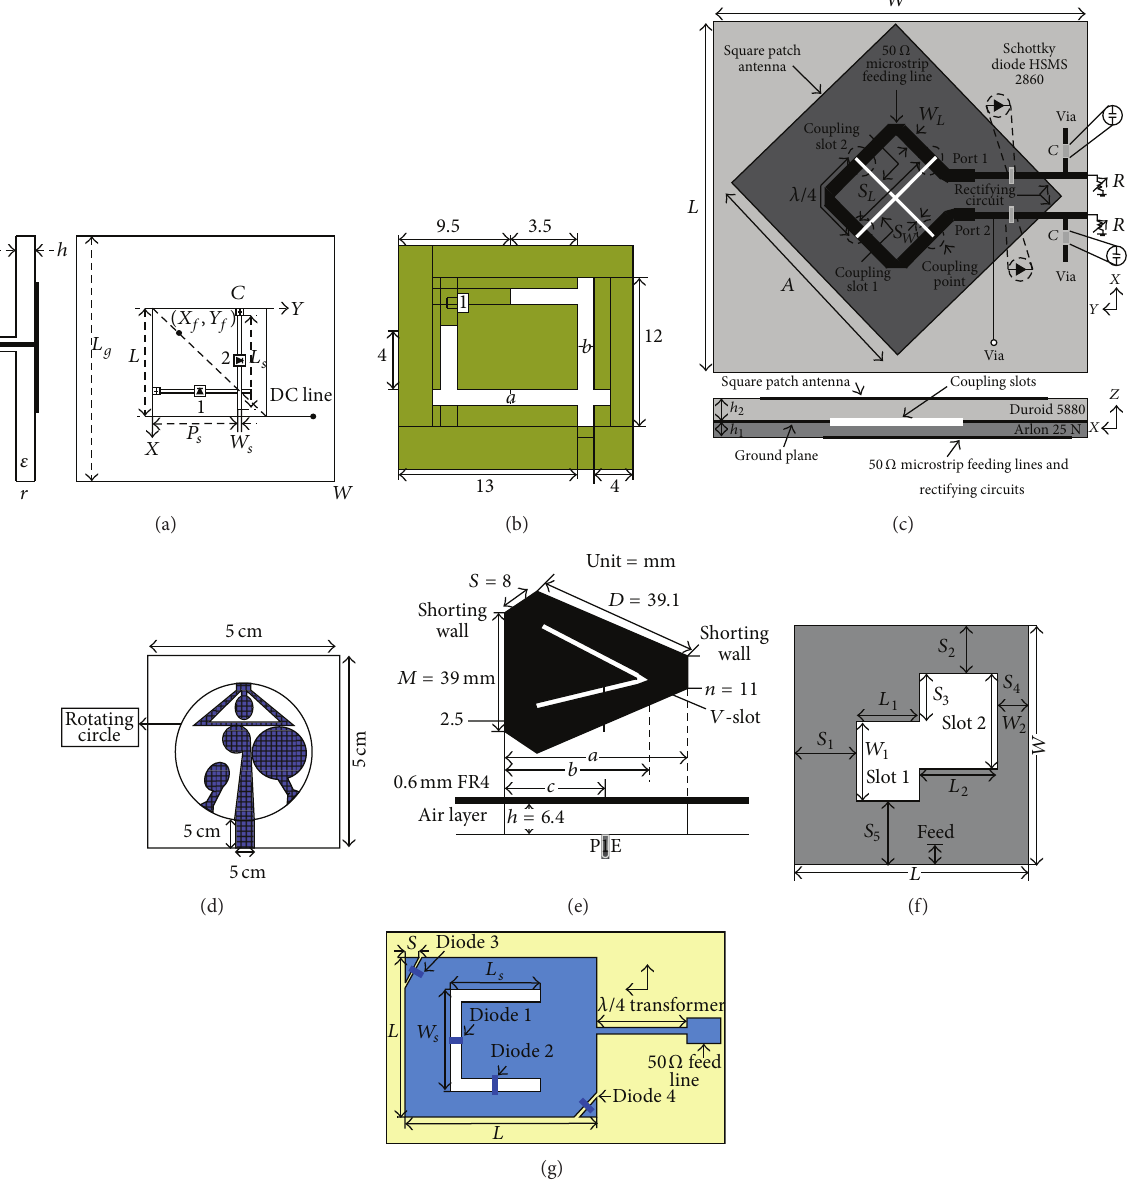
Figure 5: Various antennas designed for